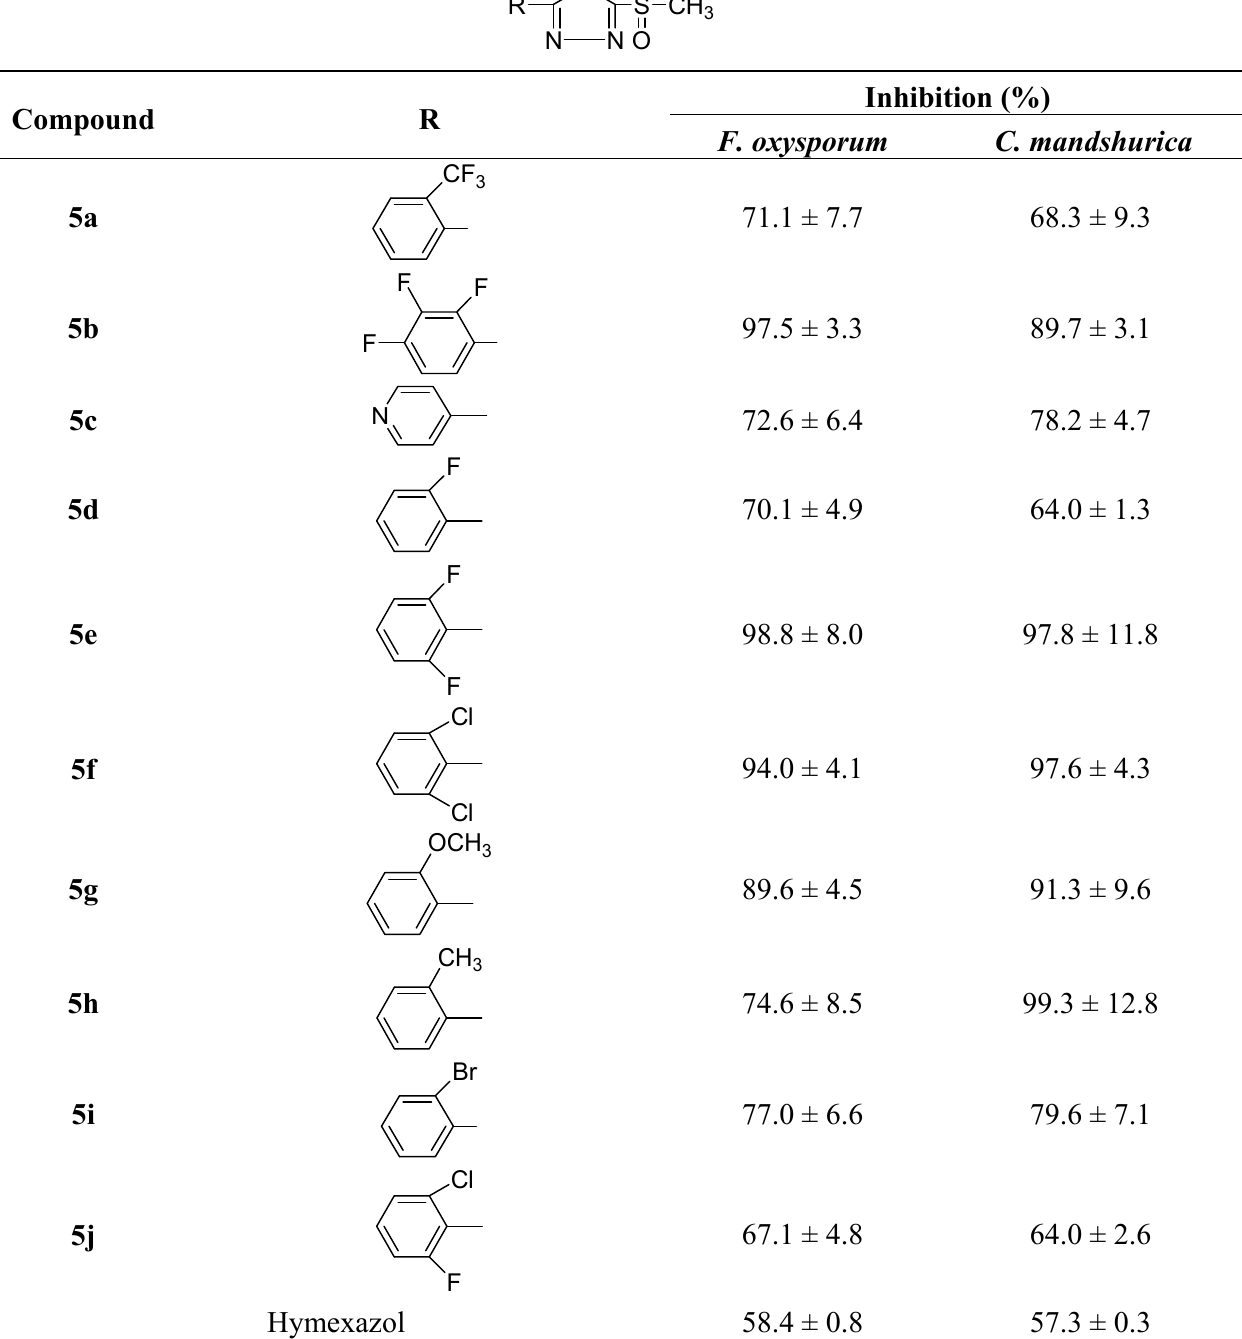
Table 1. Inhibition effect of oxadiazole methyl sulfones against phytopathogenic fungi at 50